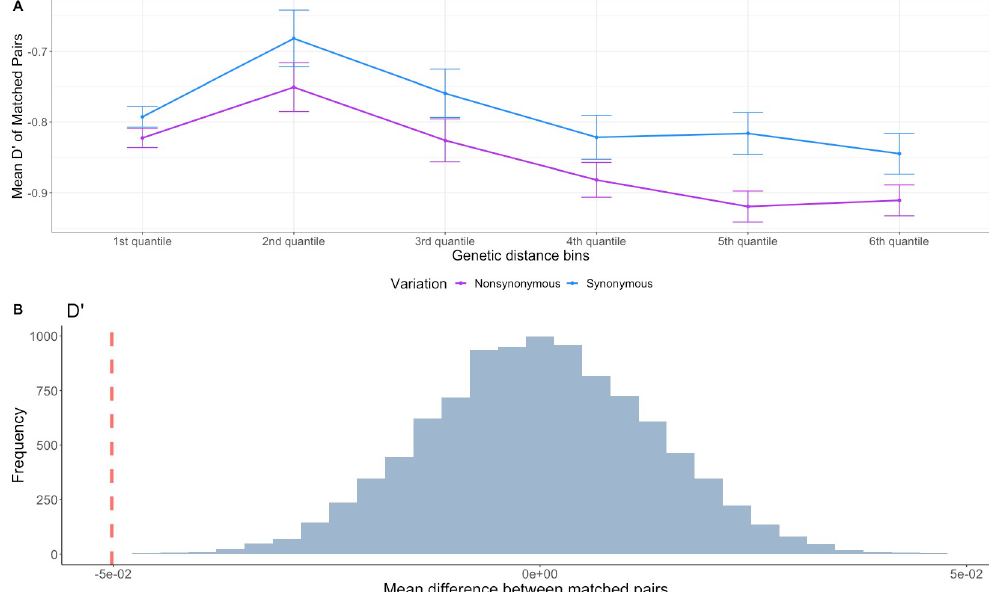
Fig 3. Pairs of NS variants have lower LD compared to pairs of S variants in human genetic variation data. (A) Pairs of low-frequency (variants with minor allele count < = 5 in a sample of 50 individuals) NS variants in the YRI population of the 1KGP have a lower (i.e. more negative) mean D ’ compared to pairs of S variants across genetic distance bins. Error bars represent one standard error of the mean and were calculated by dividing the standard deviation by the square root of the number of pairs of SNPs. (B) In the YRI population of the 1KGP, NS pairs of variants have a significantly lower D ’ compared to matched pairs of S